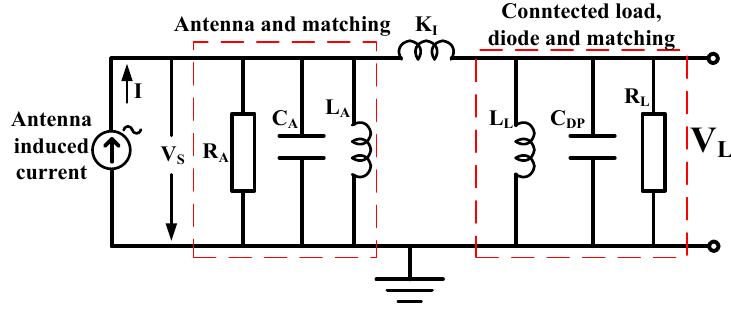
Figure 10. Inductive coupled parallel RLC small signal model of a generalized PI-matched antenna and diode